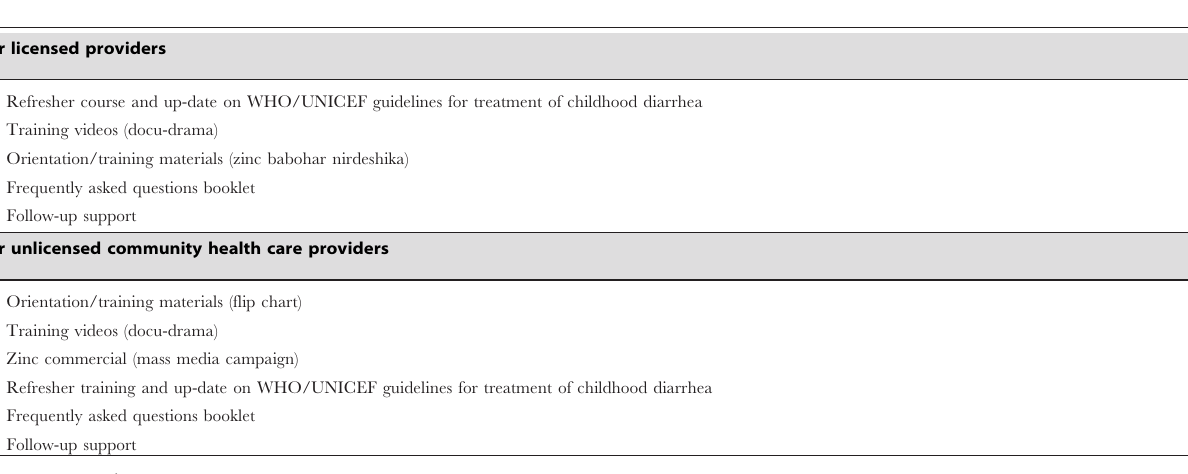
Table 1. Training Package for health care providers in the intervention area.